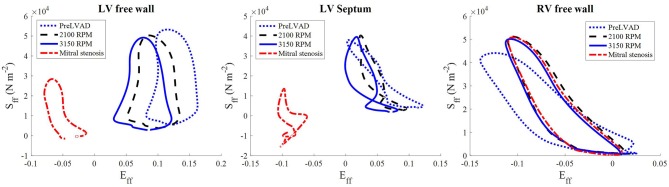
The stress-strain loops of the LVAD simulations at the third cycle (t = 1,500–2,250 ms) of stable 2,100 RPM pump speed (Left), speed increment to 3,150 RPM (Middle) at (t = 2,250–3,000 ms), and mitral stenosis (t = 1,500–2,250 ms) (Right). Sff is the 2nd Piola-Kirchoff stress and Eff is the Green-Lagrange strain tensor components along the fiber direction.